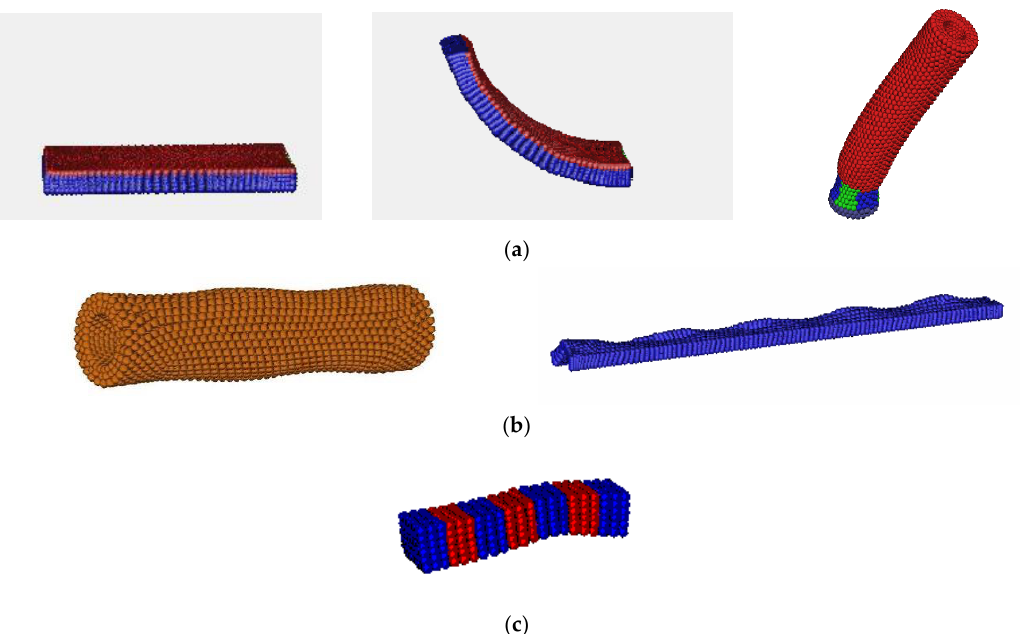
Figure 7. ( a – c ) illustrate the case studies considered in this study [26] (Reprinted with permission from [26]). ( a ) FE simu- lations carried out on an azo-doped nematic elastomer beam which has been anchored by its right edge. When the beam is exposed to light, it automatically bends in an upward. The purpose of this simulation was to numerically investigate an experiment carried out by Camacho-Lopez et al. [57]. Far left: the beam is shown to be completely in the nematic state. Before exposure, the director is oriented horizontally. Middle: a rapid upward bend is induced by the top (red) layer when it switches to isotropic state. Right: six nematic elastomer actuators (illustrated in blue and green) arrayed in a ring at the tube’s base, cause the formation of a red rubber tube. ( b ) FE simulations — Left: peristaltic motion a nematic elastomer tube. The motion is caused by periodic modulation of the scalar nematic order parameter along the tube’s length, e.g., by temperature or light. Note that The FE mesh nodes are represented as spheres. Right: peristaltic motion in a thin film, which is designed for covering and transporting the contents of a rigid. ( c ) FE simulations — A nematic elastomer, mimics the crawling motion of an earthworm.